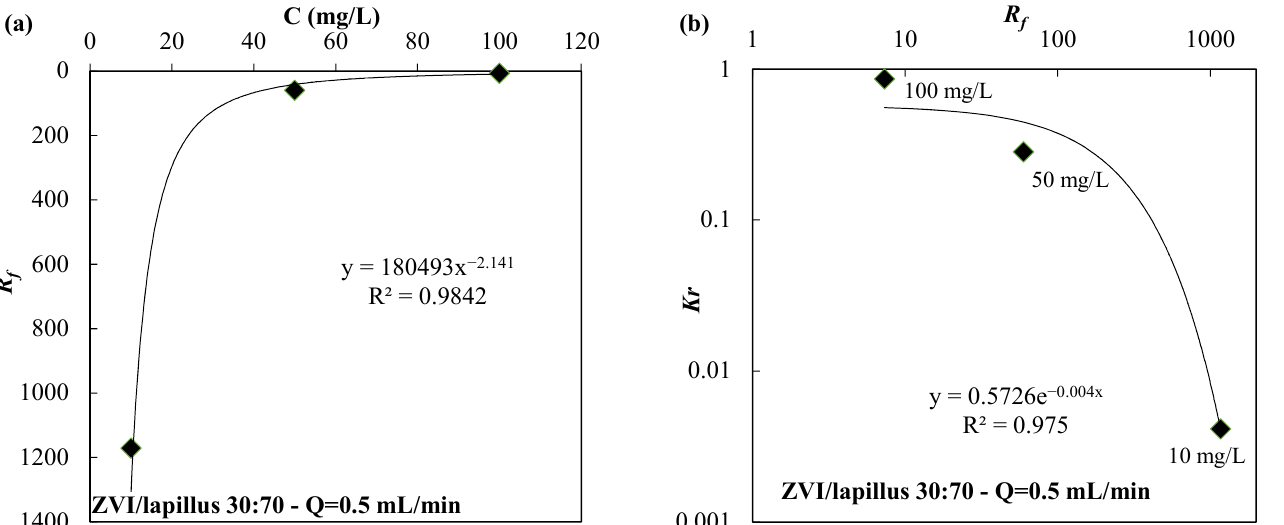
Figure 5. ( a ) R f vs. the initial nickel concentration (C) and ( b ) Kr vs. R f for the ZVI/lapillus granular mixture.